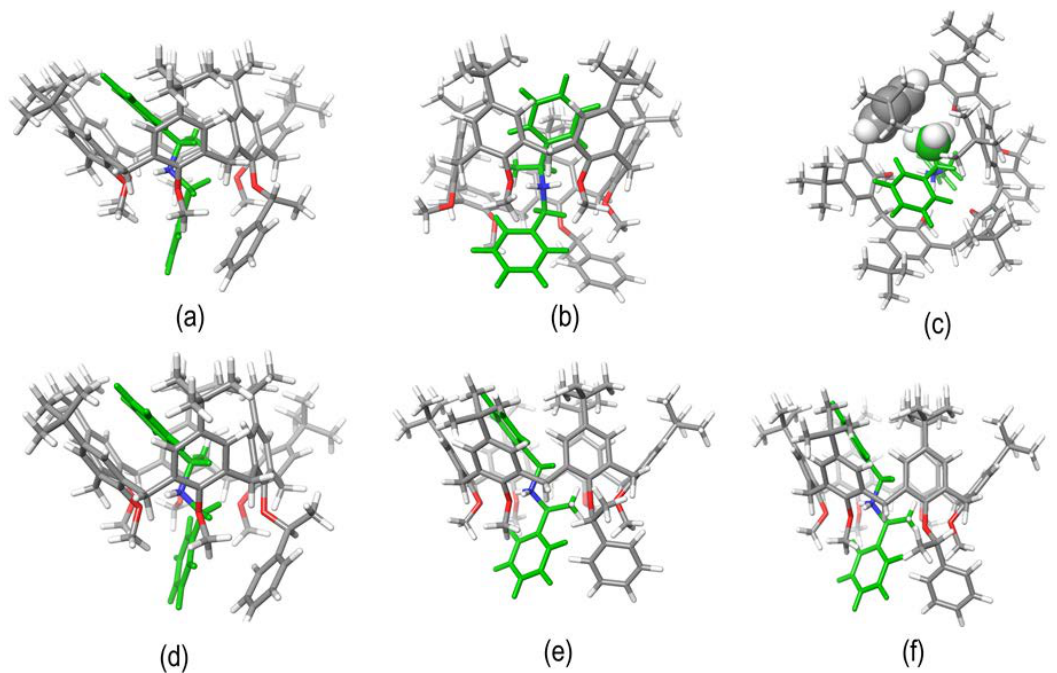
Figure 7. DFT optimized structures at the B97D3/SVP/SVPFIT level of theory of the stereoisomeric exo- chiral and endo -chiral 9 + @4 pseudorotaxanes. ( a ) endo -chiral ( S )- 9 + @ ( S )- 4 pseudorotaxane. ( b ) Particular of the + NH axle ∙∙∙OR calix H-bonding interactions in ( S )- 9 + @ ( S )- 4 . ( c ) Particular of the C-H∙∙∙ π interactions in ( S )- 9 + @ ( S )- 4 . ( d ) endo -chiral ( S )- 9 + @ ( R )- 4 pseudorotaxane. ( e ) exo -chiral ( S )- 9 + @ ( R )- 4 pseudorotaxane. ( f ) exo -chiral ( S )- 9 + @ ( S )- 4 pseudorotaxane.